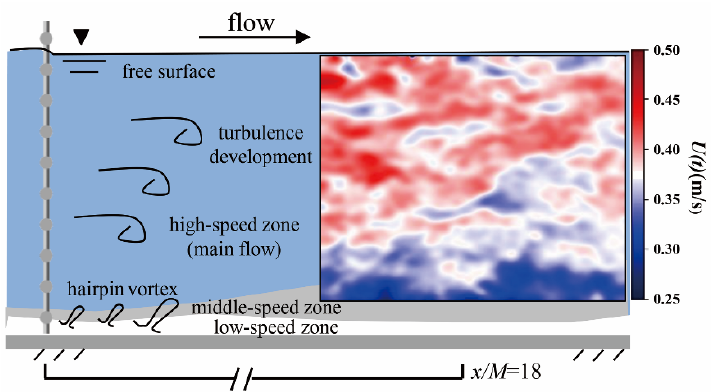
Figure 4. Different flow zones in open channel [38] and instantaneous velocity centered at x / M = 18.